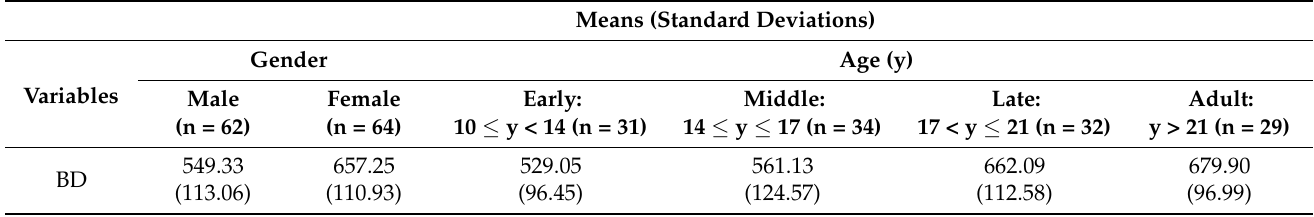
Table 2. Midpalatal bone density (BD) according to gender and age (HU).